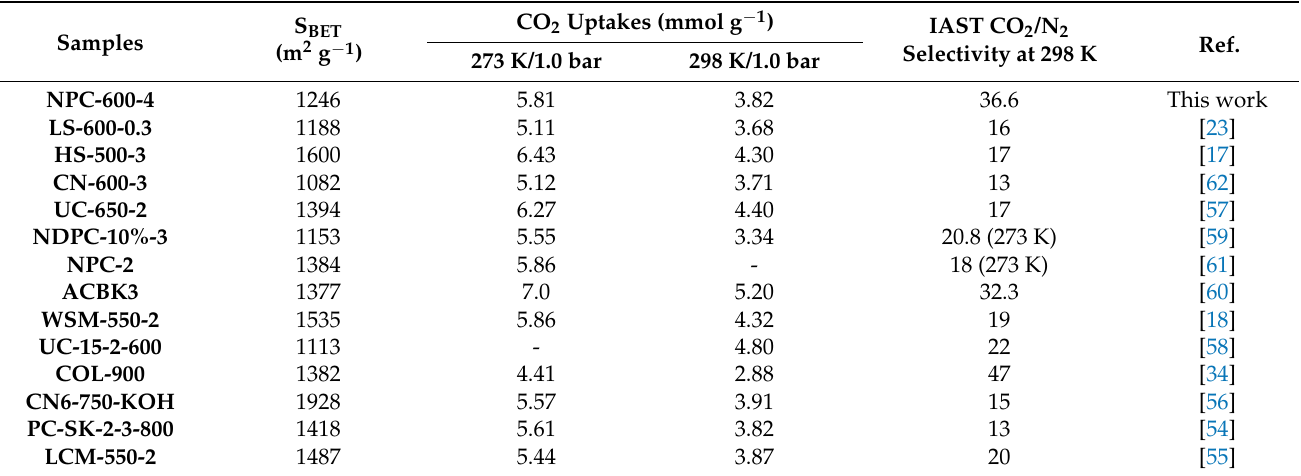
Figure 11. IAST CO 2 /N 2 adsorption selectivity of NPC-700-x ( a ) and NPC-y-4 ( b ) at 298 K. Table 4. Comparison of CO 2 adsorption values and CO 2 /N 2 selectivity from reported N-doped porous carbons.